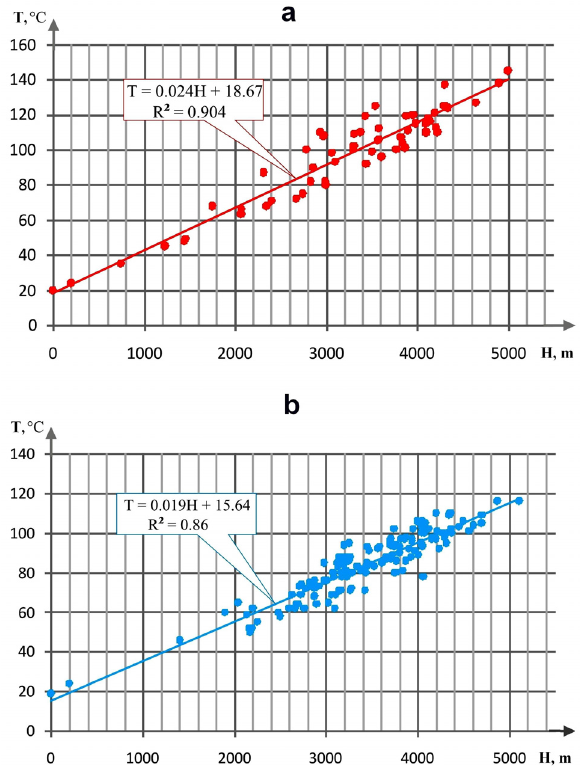
Figure 2. Graphs of the temperature dependence on the depth in oil deposit Muradkhanly: (a) inside the deposit contour, (b) outside the deposit contour. H is depth, and R is the correlation